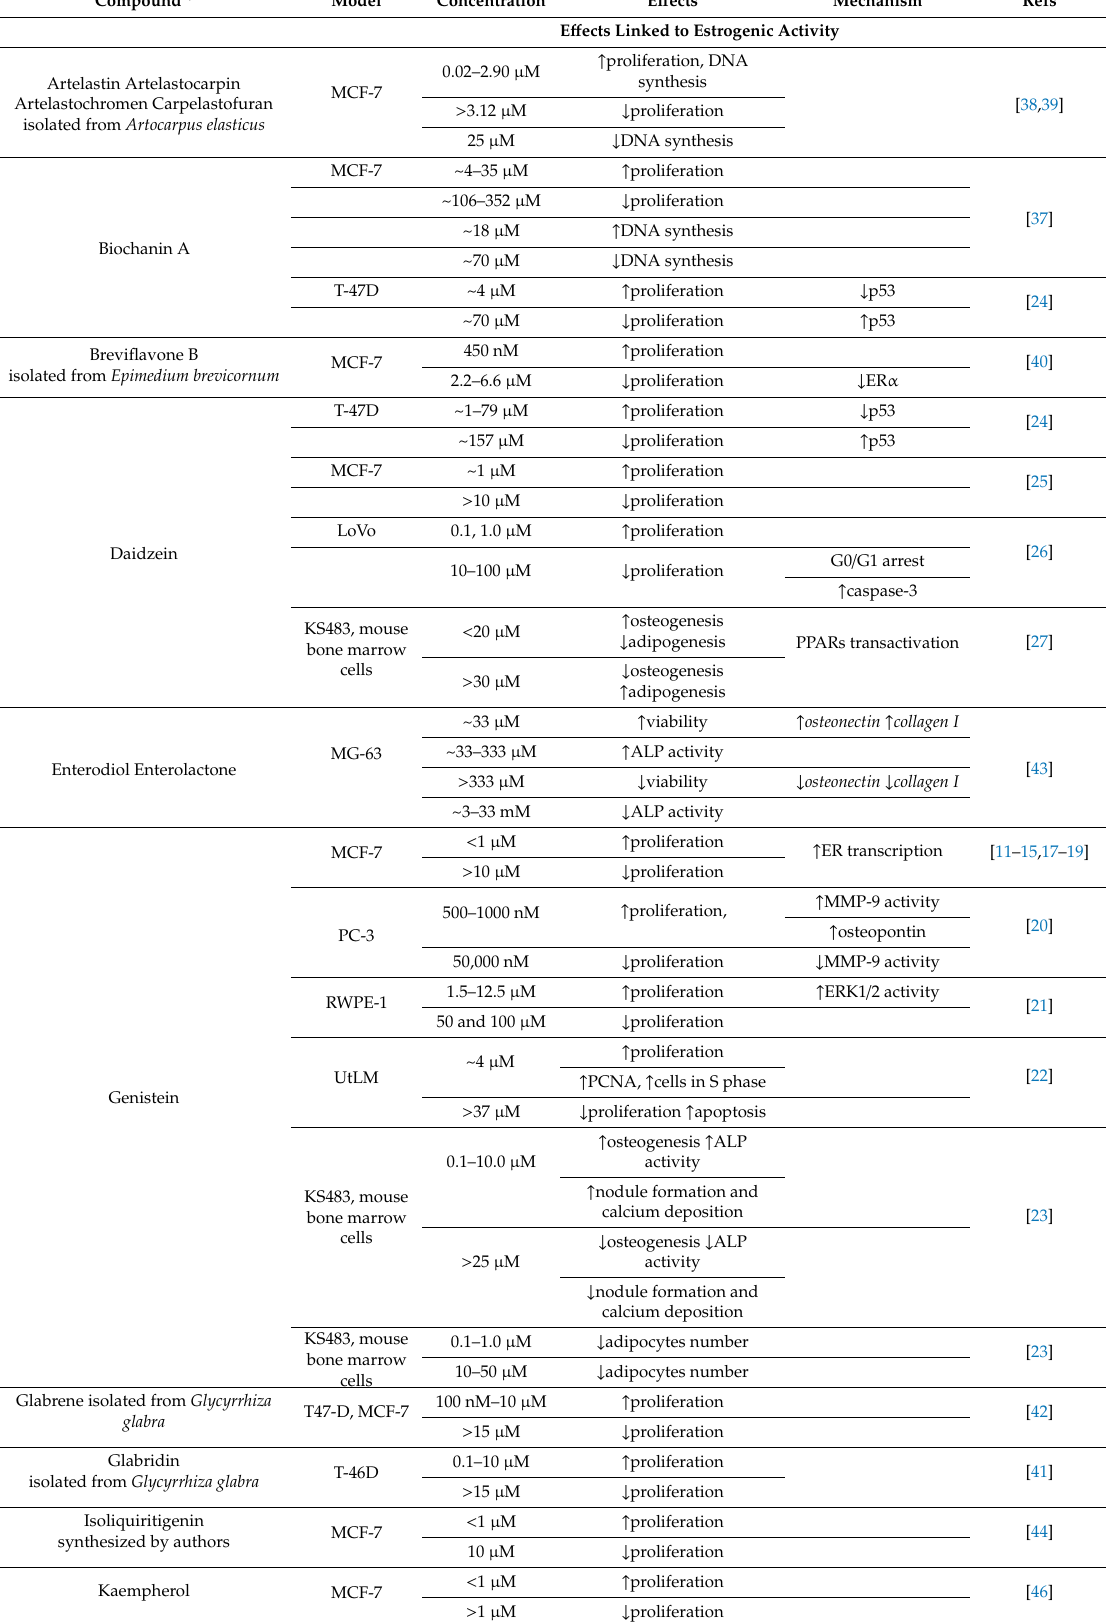
Table 1. Phytoestrogens displaying biphasic concentration-response